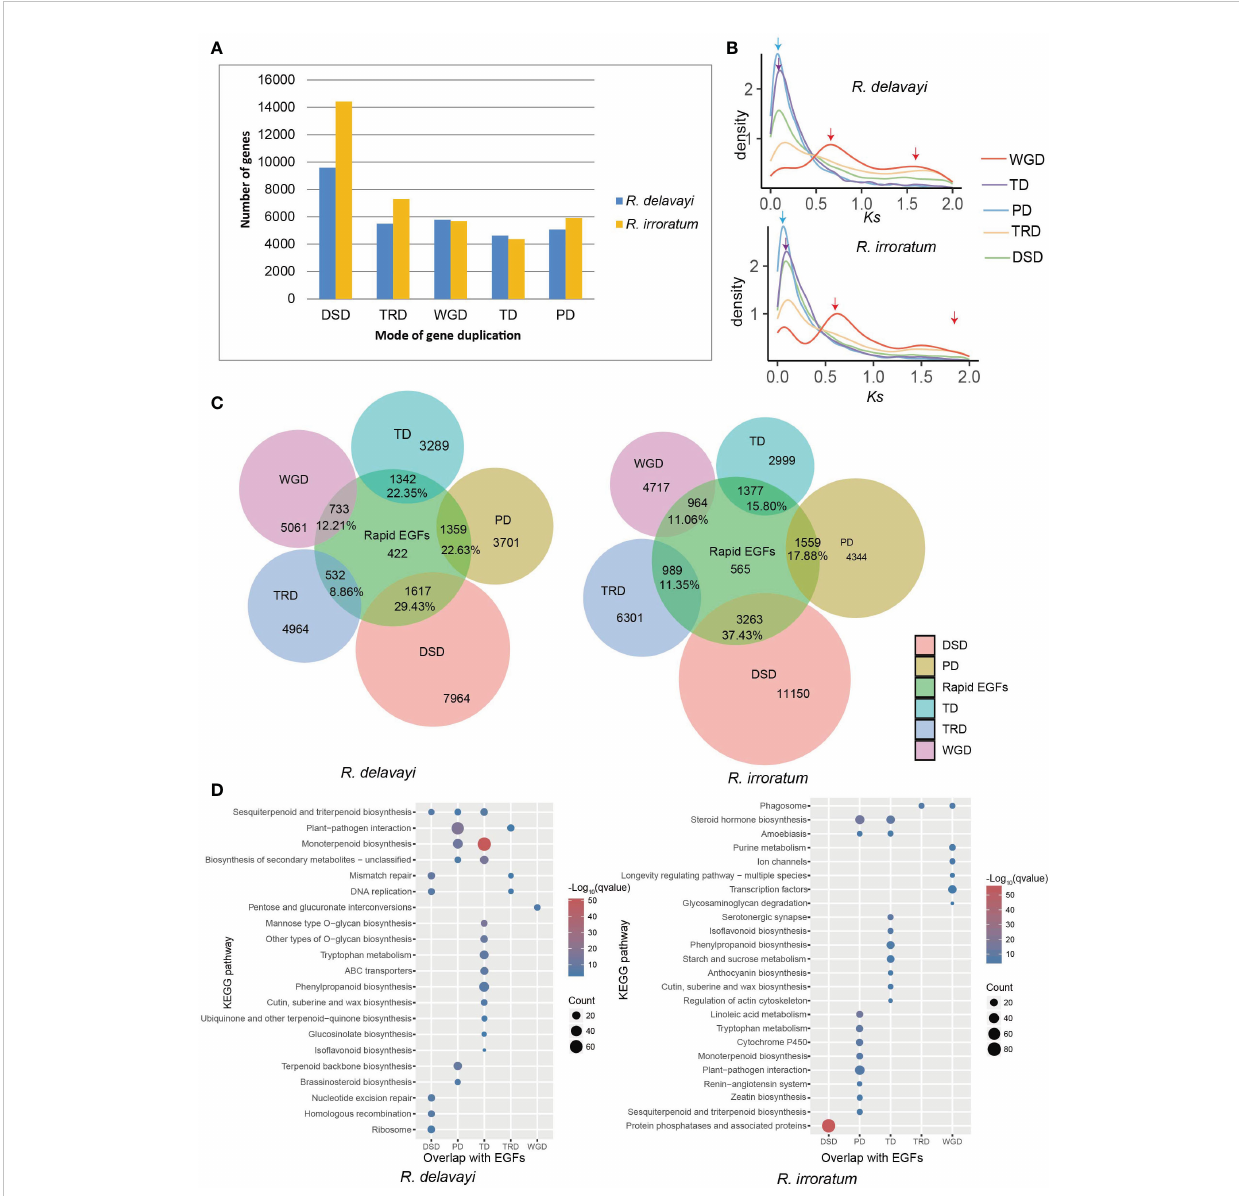
FIGURE 3 Gene duplication in Rhododendron and its contribution to gene family expansion. (A) Number of different kinds of duplicated genes in R. delavayi and R. irrorarum . WGD, whole-genome duplication; TD, tandem duplication; PD, proximal duplication; TRD, transposed duplication; DSD, dispersed duplication. (B) The Ks distributions of gene pairs derived from different modes of duplication. The red, purple, and blue arrows indicated the Ks peak of WGD-derived, TD-derived and PD-derived genes, respectively. (C) The relations between members of rapid expanded gene family (rapid EGFs) and members derived from different modes of duplication in R. delavayi and R. irroratum . (D) KEGG enrichment of genes in rapid EGFs and the different modes by which these genes have duplicated. The color and size of the circles represent statistical signi fi cance and the number of genes in a KEGG pathway, respectively; ‘ qvalue ’ is the correted P